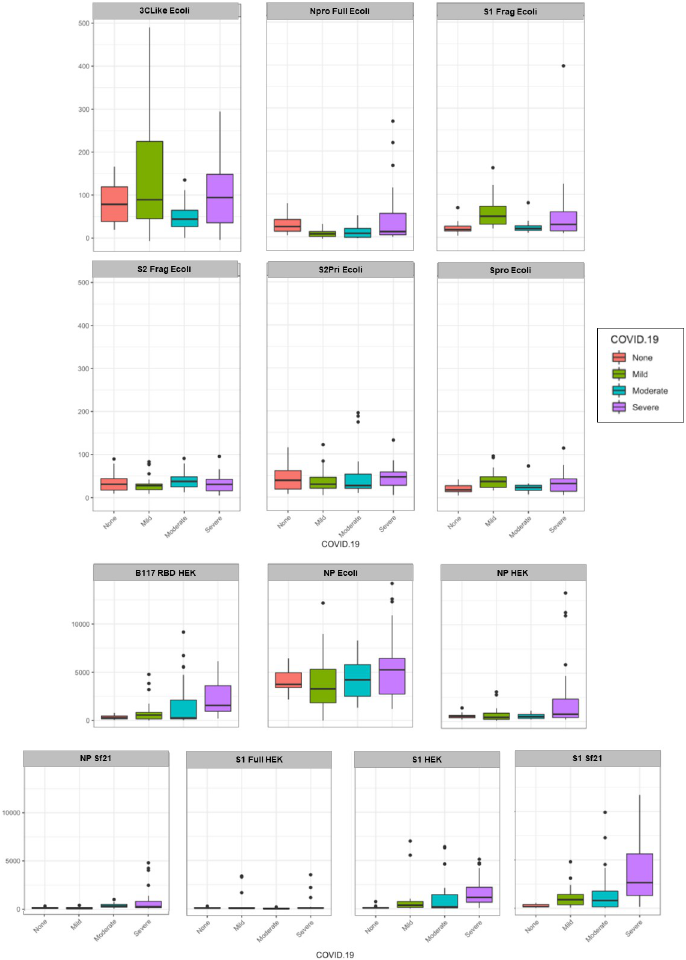
Fig 5. Serum IgM samples by COVID-19 disease severity (mild, moderate, severe) binding to the various SARS-CoV-2 protein antigens compared to no disease (NC). Each antigen was plotted using a boxplot with relative fluorescence intensity of binding on the y-axis and COVID-19 disease cohort on the